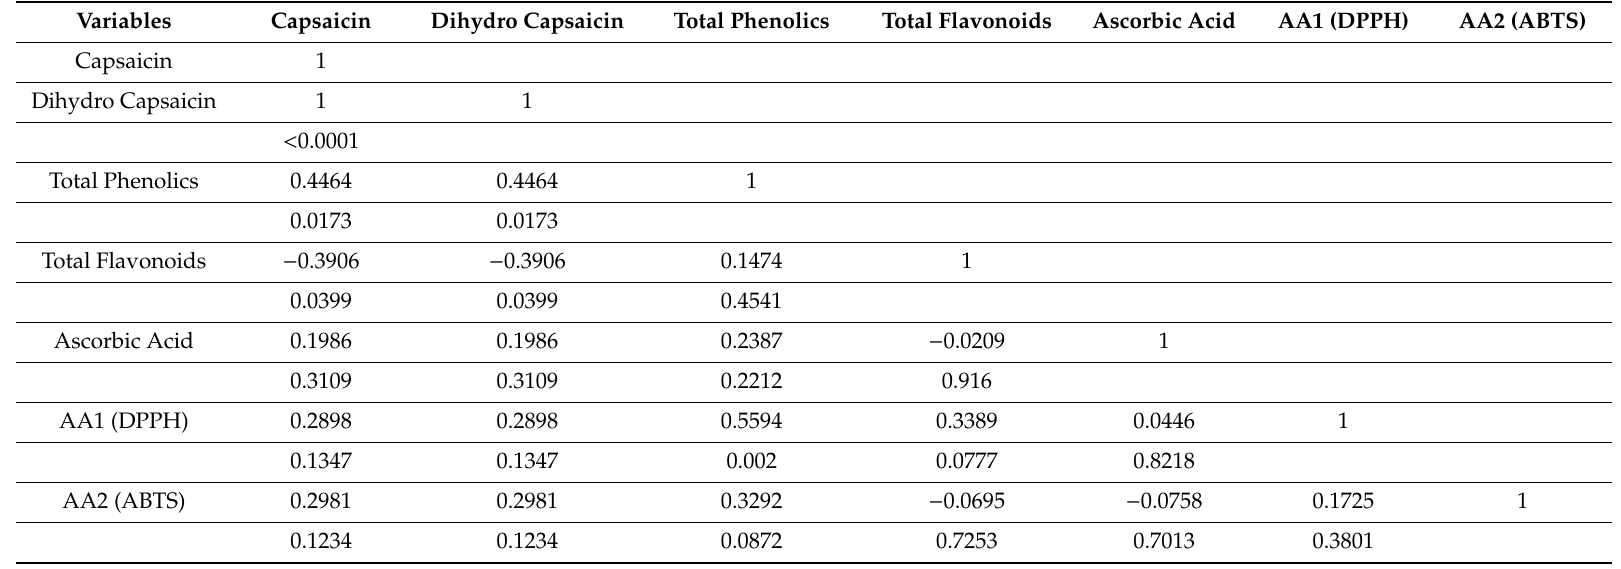
Table 3. Pearson’s correlation coe ffi cient analysis among capsaicin, dihydrocapsaicin, total phenolics, total flavonoids, and antioxidant